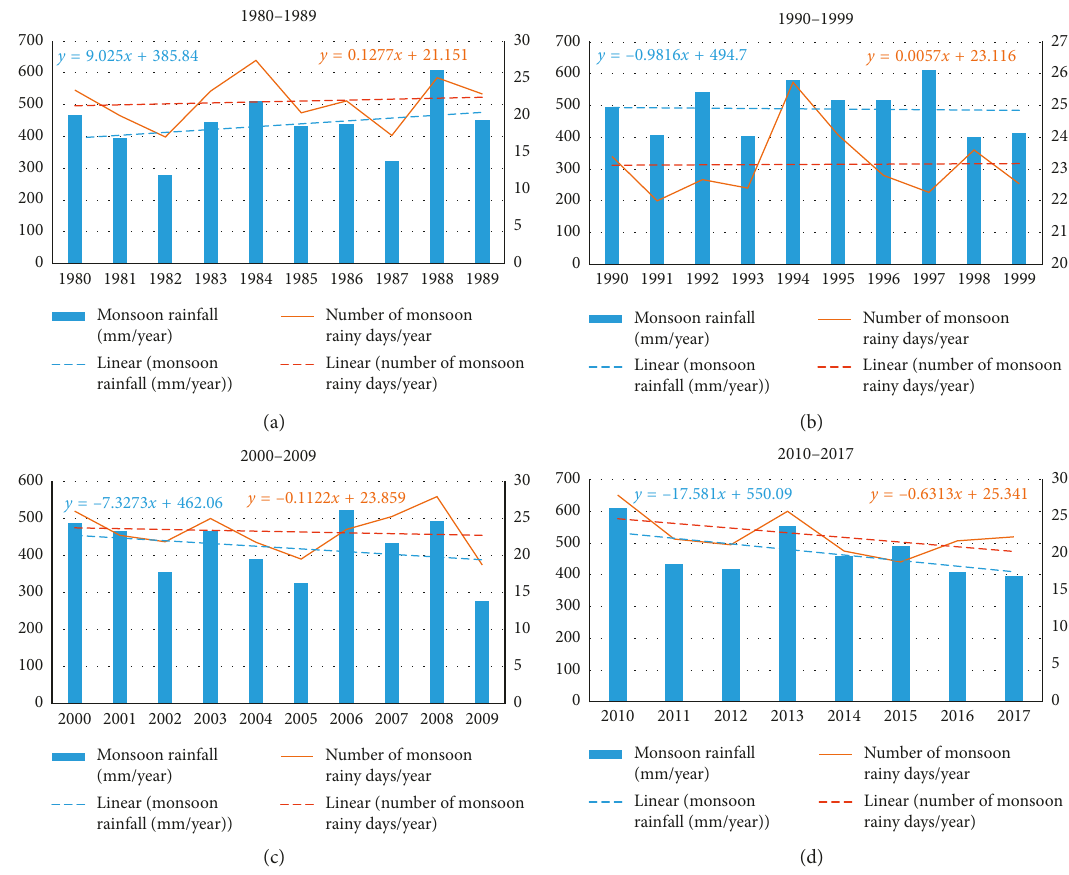
Figure 8: Decadal variation in number of rainy days for the monsoon season over Pakistan; the last two decades depict a decrease in the rainy days and monsoon rainfall in the study region.